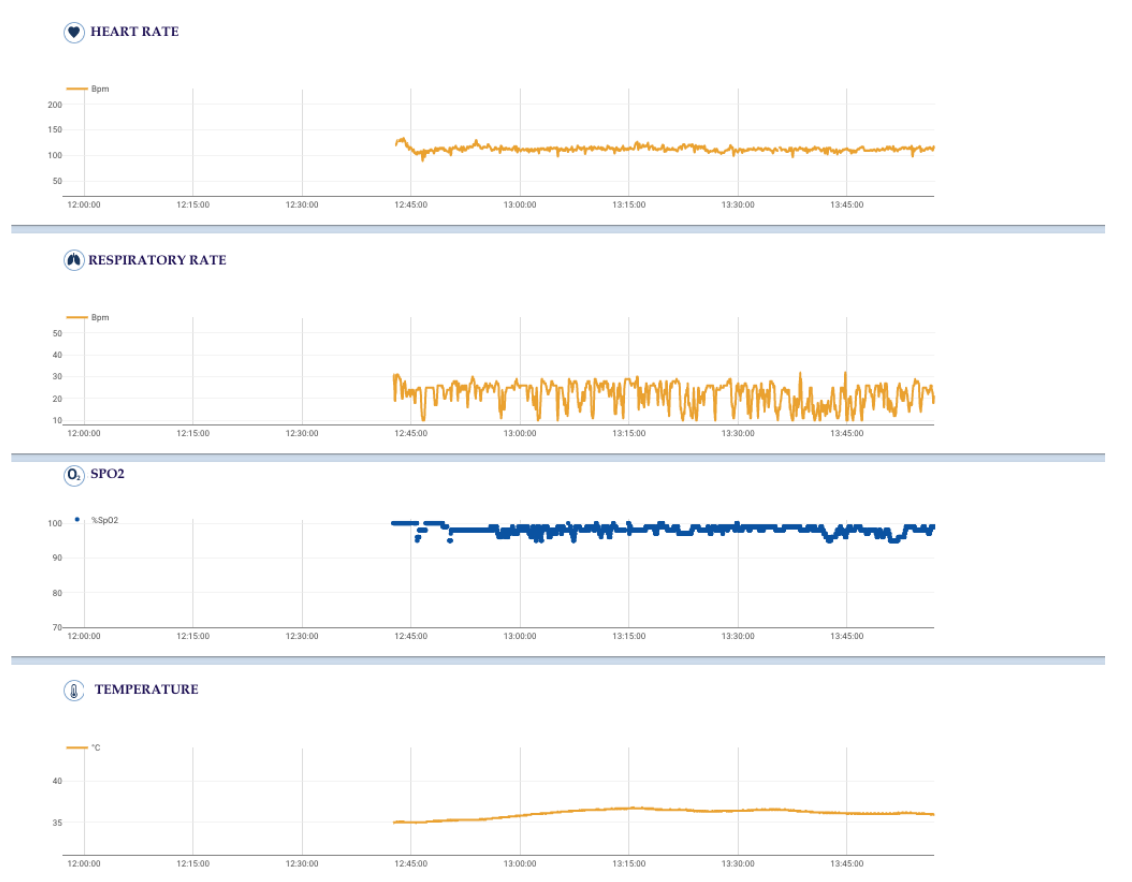
Figure 1. Physiological parameters of a single intervention (start time: 12:38, end time: 14:00), each with its own sampling frequency, acquired using the sensorized Healer R2 garment and elaborated using the Healer software.